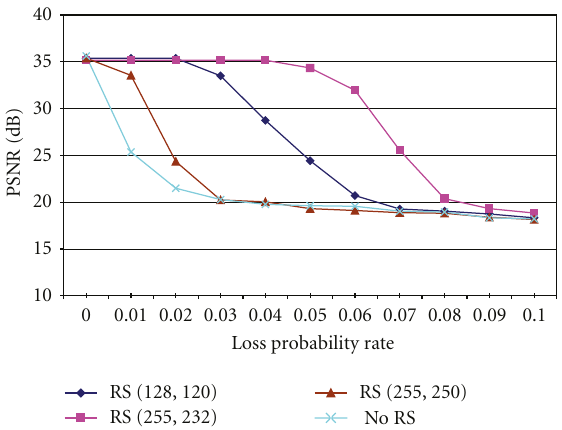
Figure 10: PSNR evolution for “Foreman” sequence in CIF resolution over a packet erasure channel for di ff erent protection levels with RS